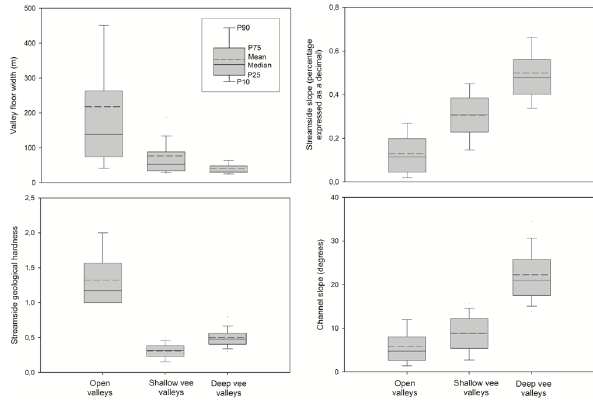
Fig. 6. Boxplots of the four variables involved in the river reach classification for the three geomorphological valley